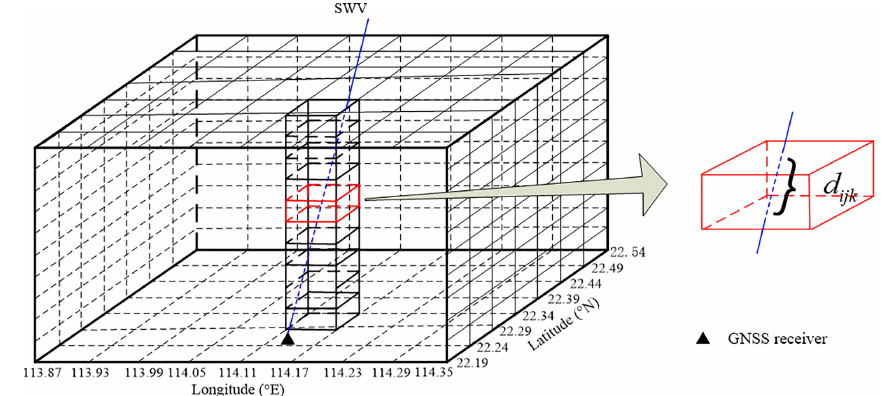
Figure 1. Geometric illustration of a signal ray crossing the discretized